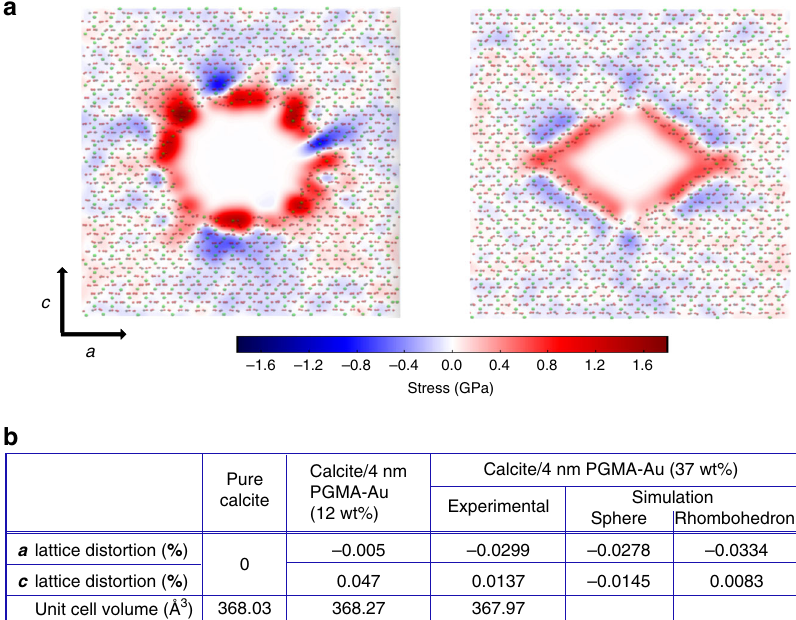
Fig. 9 MD simulations of the stress fi eld associated with an occlusion in a PGMA-Au/calcite composite crystal. a Plots of hydrostatic stress fi eld in calcite arising from a spherical hole (left) and rhombohedral hole (right). In each case, red represents areas under tension and blue areas under compression. The hole induces a local tension stress on the interface that is compensated for by contraction of the surrounding matrix. b Table comparing lattice distortions (%) and unit cell volumes obtained from experiments and simulations.